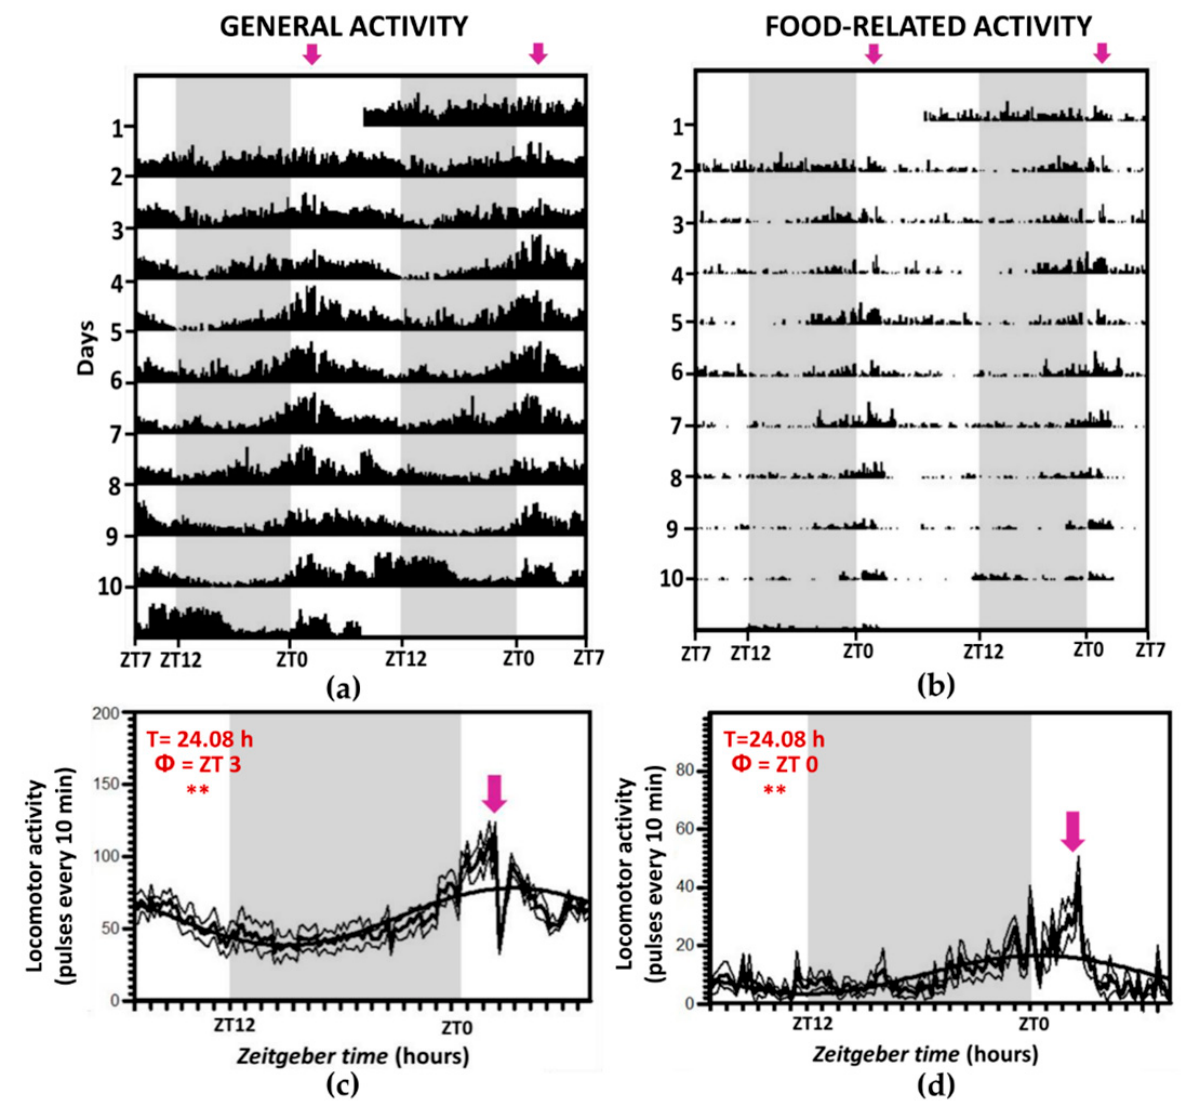
Figure 1. Locomotor activity (general ( a , c ) and food-related ( b , d )) for group LD-2, with a 12L:12D photoperiod and fed at ZT 2. The shaded zones indicate the darkness period, and the arrows point to the feeding time. ( a , b ): double-plot actograms, in which the X-axis represents the time of the day of two consecutive days, and the Y-axis represents the days on which activity was registered. ( c , d ): Average waveform of locomotor activity (same data). Data are expressed as mean ± SEM. Acrophase ( φ ) and significance of the Rayleigh test for a 24-h rhythm are shown ** p < 0.01. T = rhythm period (when significant) according to Sokolove–Bushell